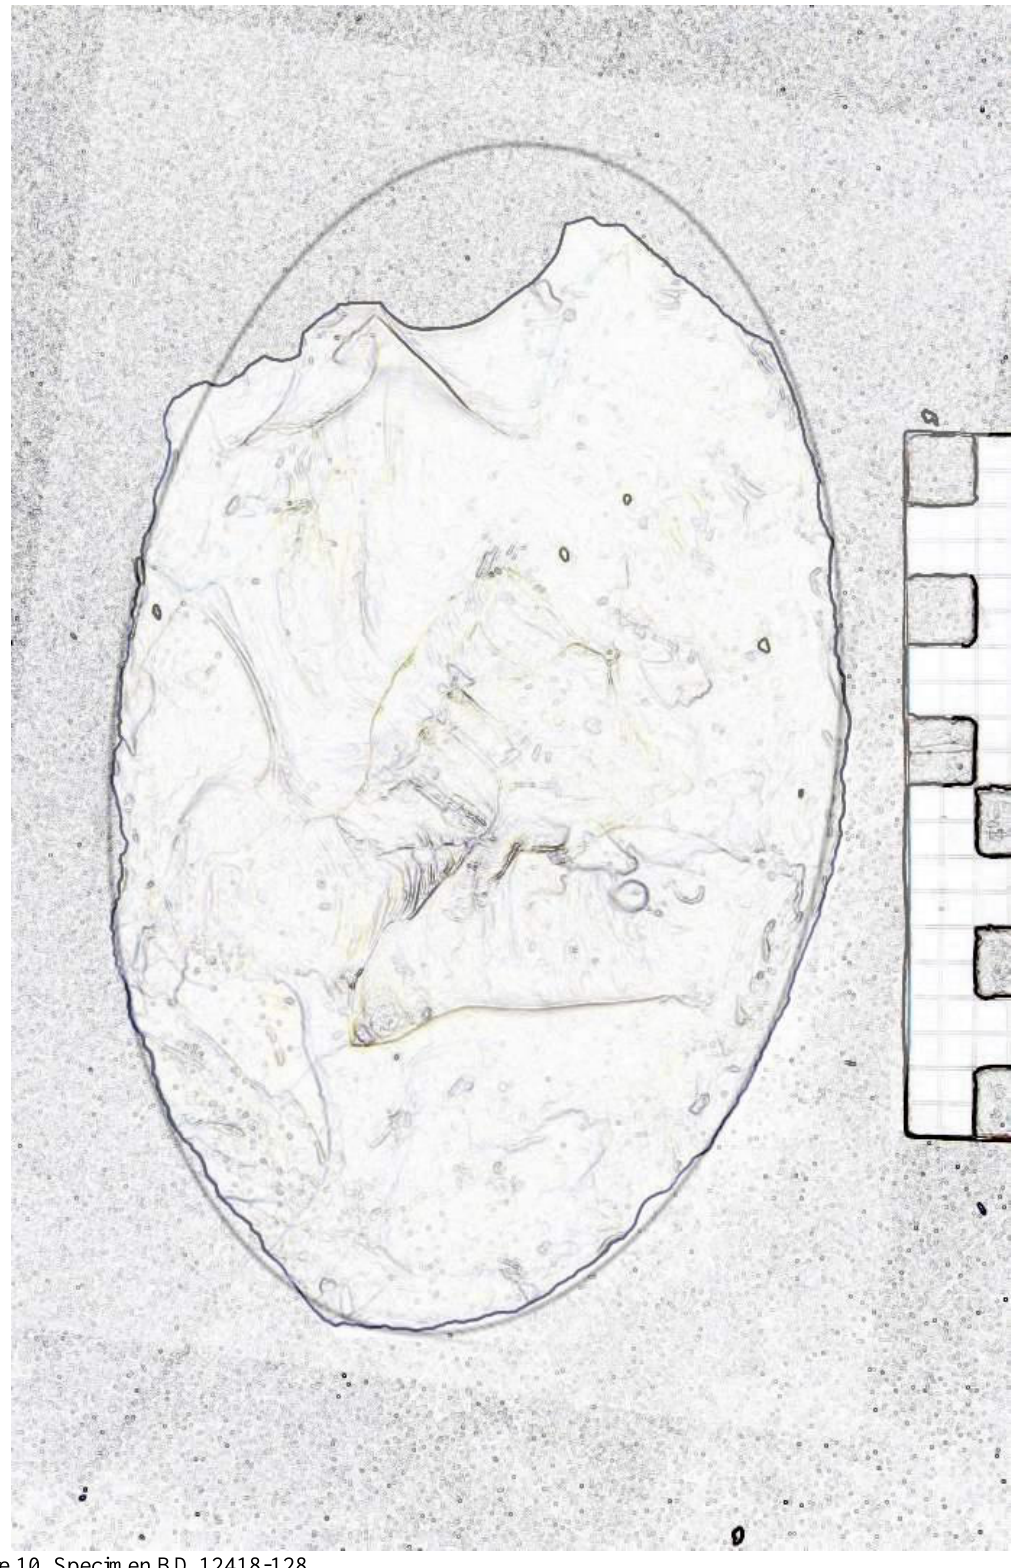
Figure 10. Specimen BD